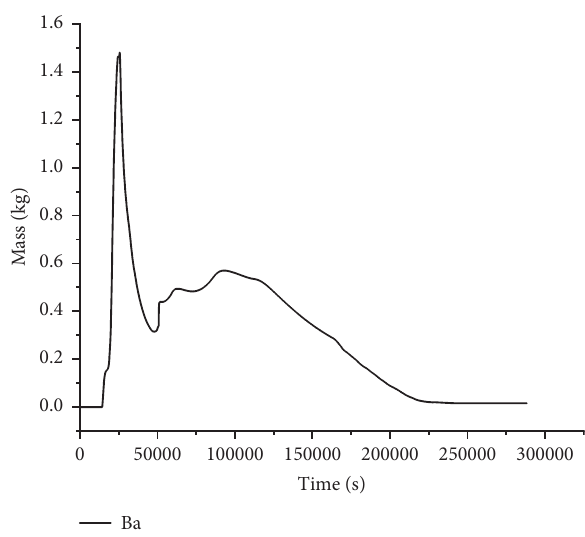
Figure 14: Release of Ba in the containment.